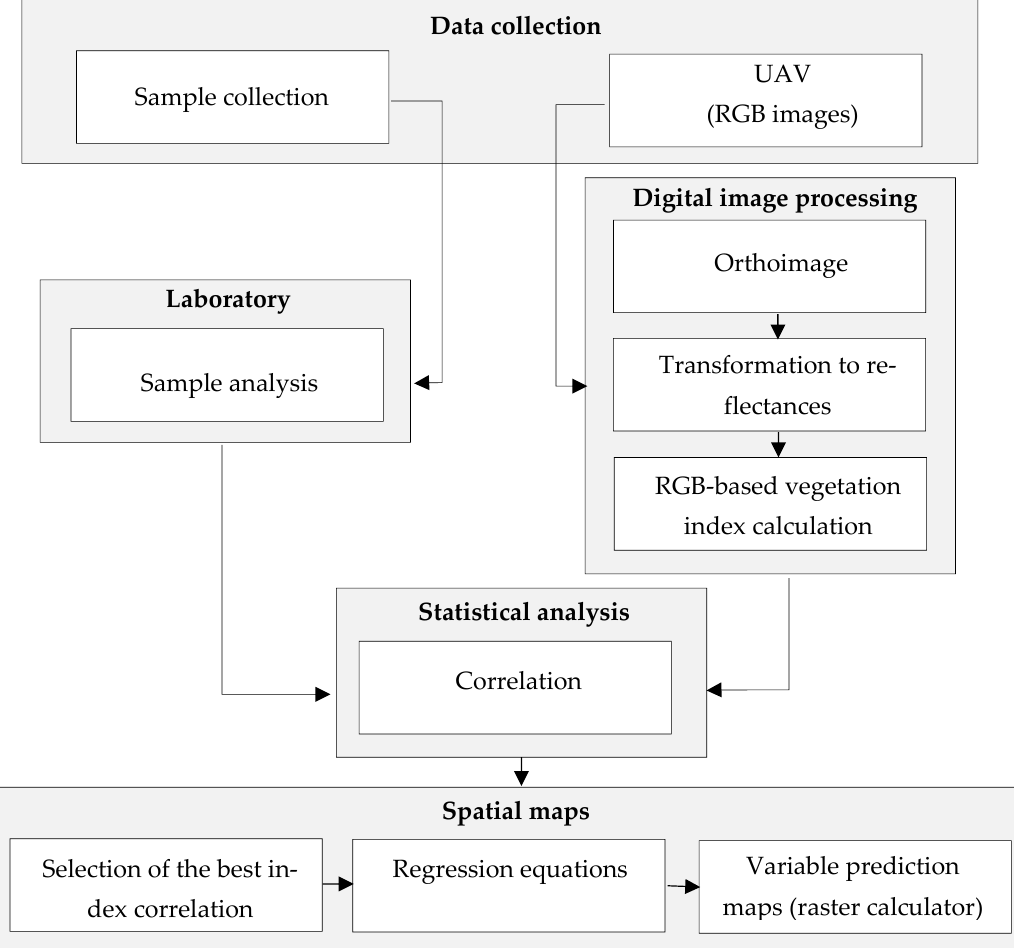
Figure 1. Flowchart illustrating the study methodology.